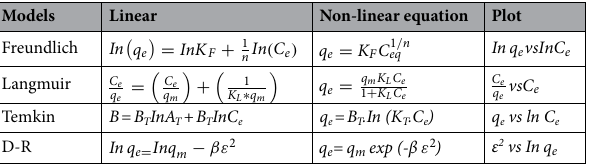
Table 8. Linear and non-linear models of Langmuir, Freundlich, Temkin and D-R